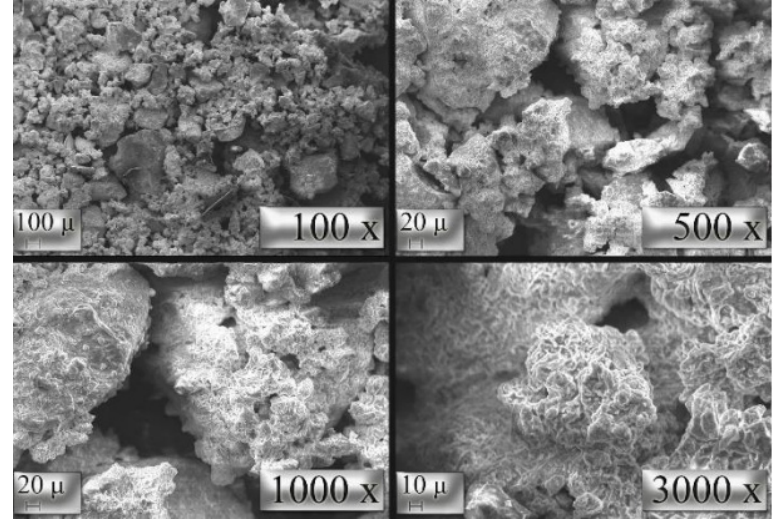
Figure 3. Scanning electron microscope (SEM) micrograph of dried sludge at a magnification of 100 to 3000 ×.